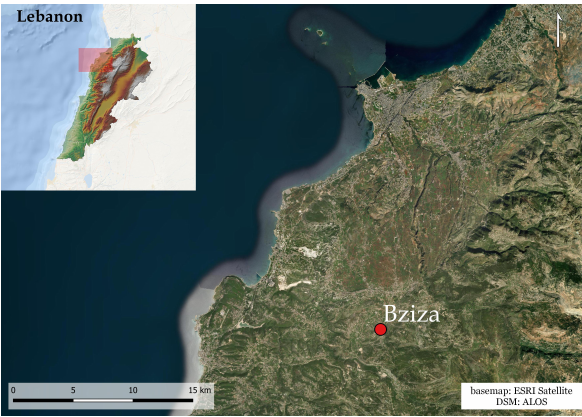
Figure 3. Historical pictures of the Bziza temple, after Fani (1995) – upper left corner – and Taylor (1971),